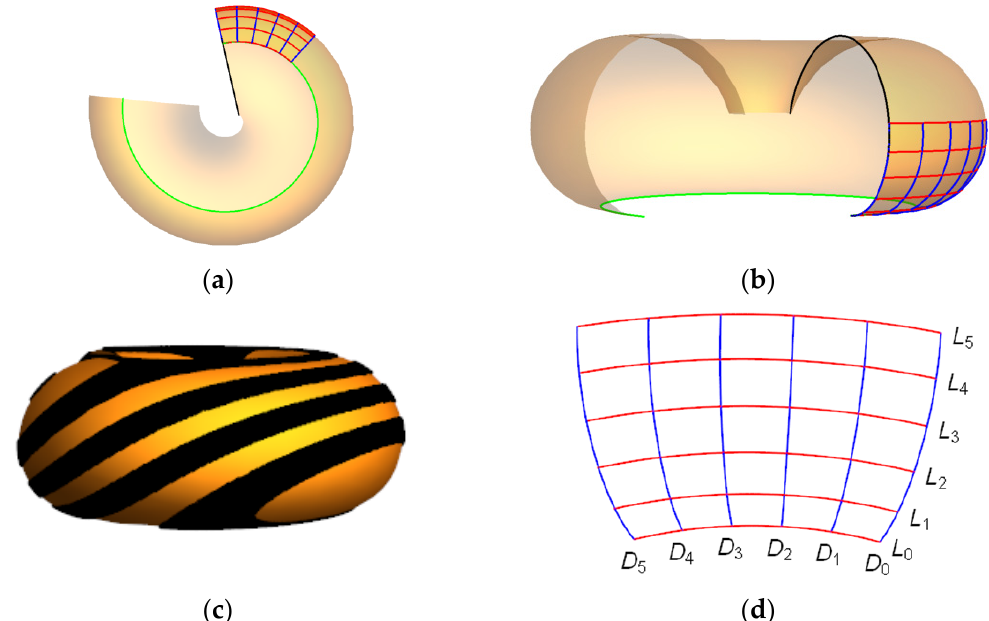
Figure 4. LA swept surface: ( a ) Top view; ( b ) Side view; ( c ) Zebra map on LA swept surface; ( d ) One part of LoCs on the LA swept surface.